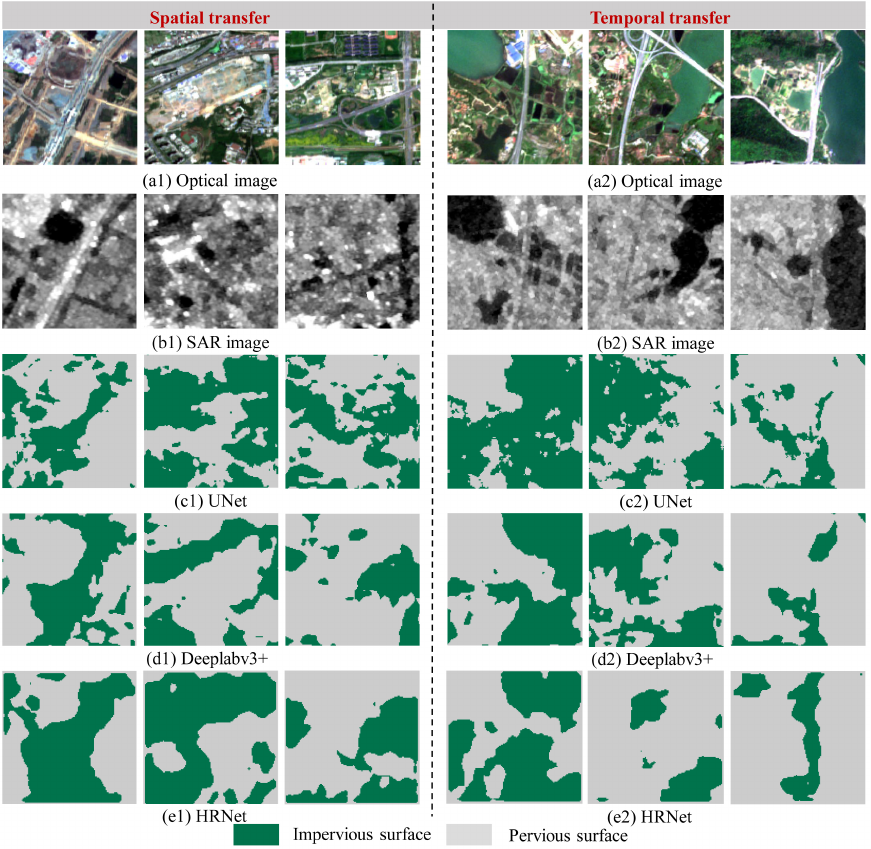
Figure 13. Spatial and temporal transfer results of UNet, Deeplabv3+, and HRNet. ( a1 – e1 ) Impervious surface extraction results of models spatial transfer. ( a2 – e2 ) Impervious surface extraction results of models temporal